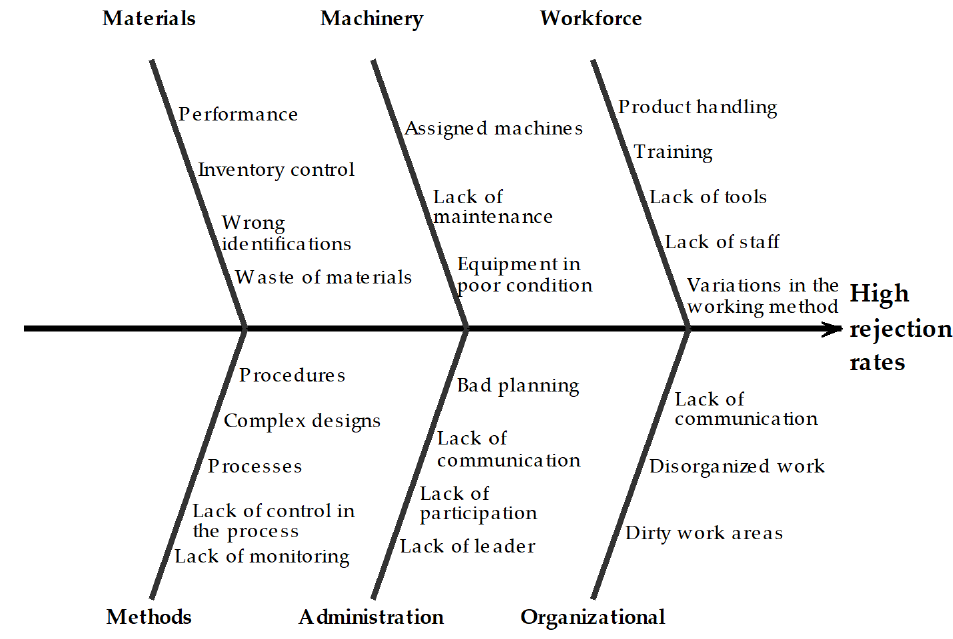
Figure 4. Ishikawa diagram.